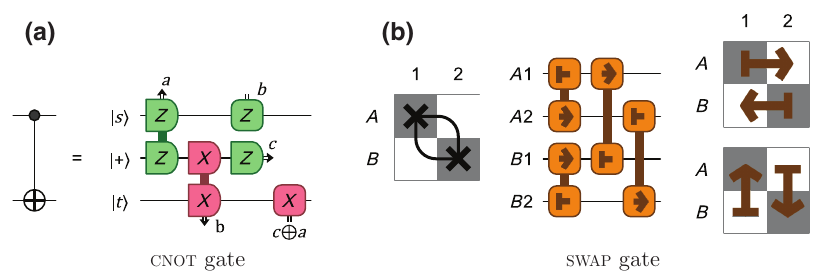
FIG. 3. A CNOT gate can be implemented in depth 2 using ZZ and XX joint measure- ments with a |+(cid:4) ancilla state, followed by classically controlled Pauli corrections. The SWAP gate can be implemented using four move operations and two ancillae in depth 2.